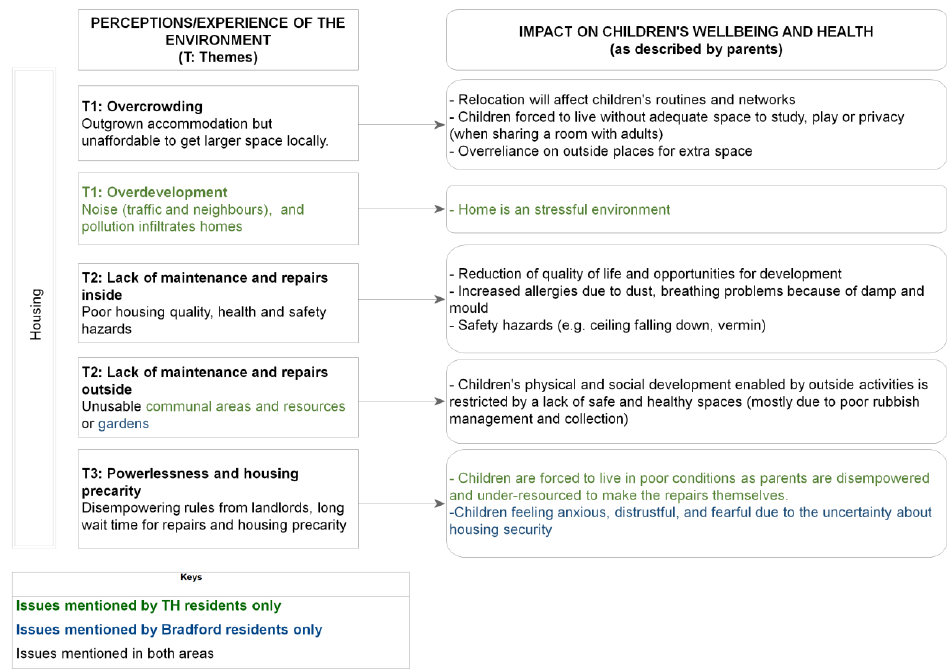
Figure 3. Housing themes and effect on